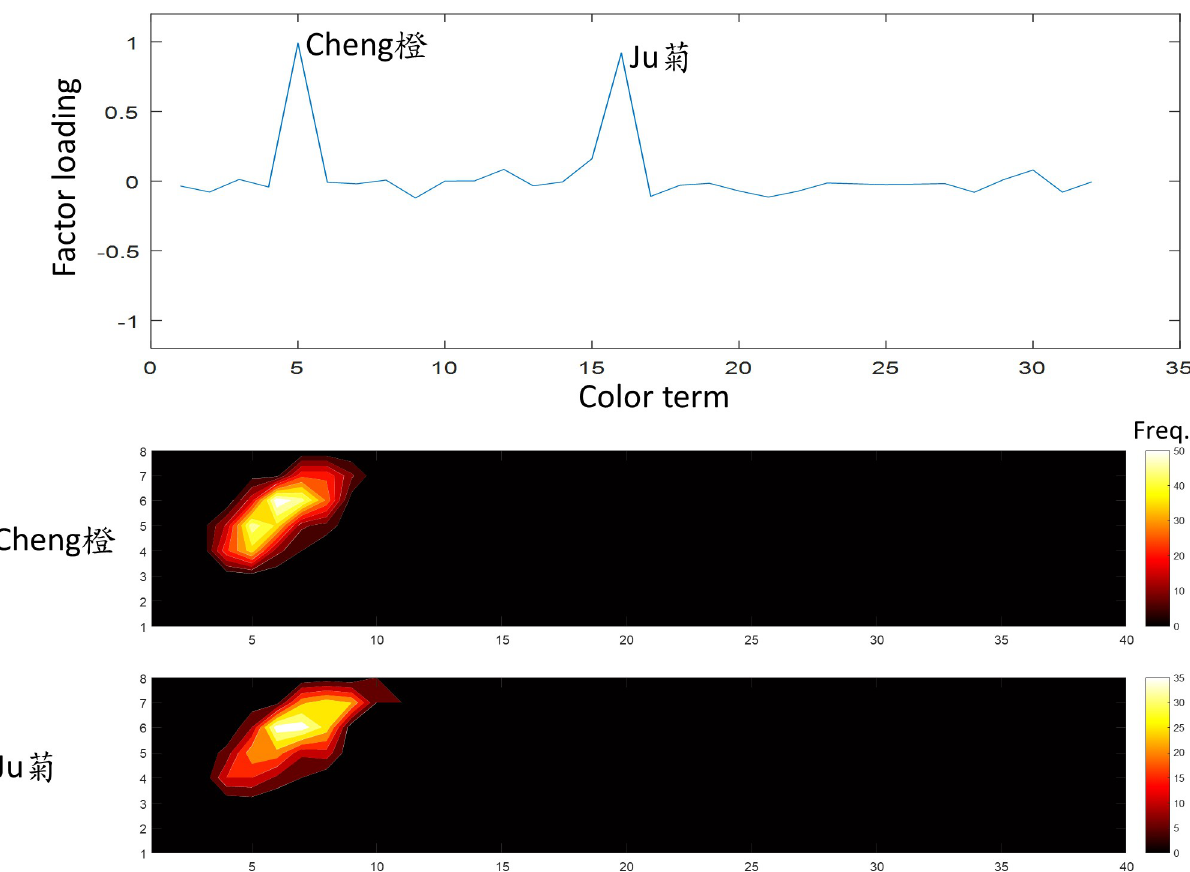
Fig 8. The fourth factor was “black”. The terms Hei , Mo and Xuan ( 黑 , 墨 , 玄 )showed a high loading on this factor. The convention of the figure is the same as Fig 5.